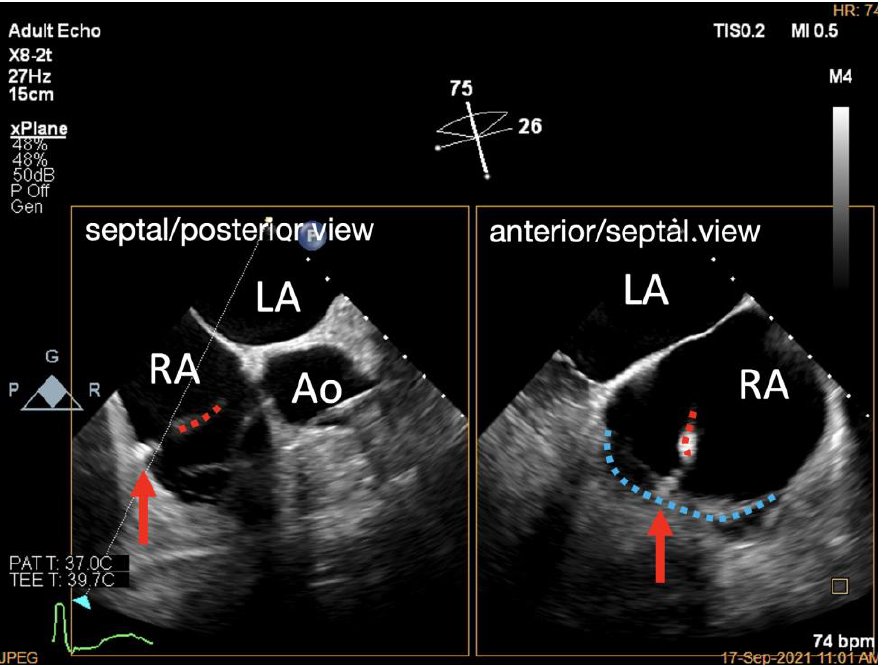
Figure 6. X-Plane work plane of K-Clip ™ implantation. X-Plane work plane showing tapping screw (red arrow) anchored into the predetermined TA location (delivery catheter shown in red dotted line, posterior TA shown in blue dotted line). LA, left atrium; RA, right atrium; Ao, aorta.